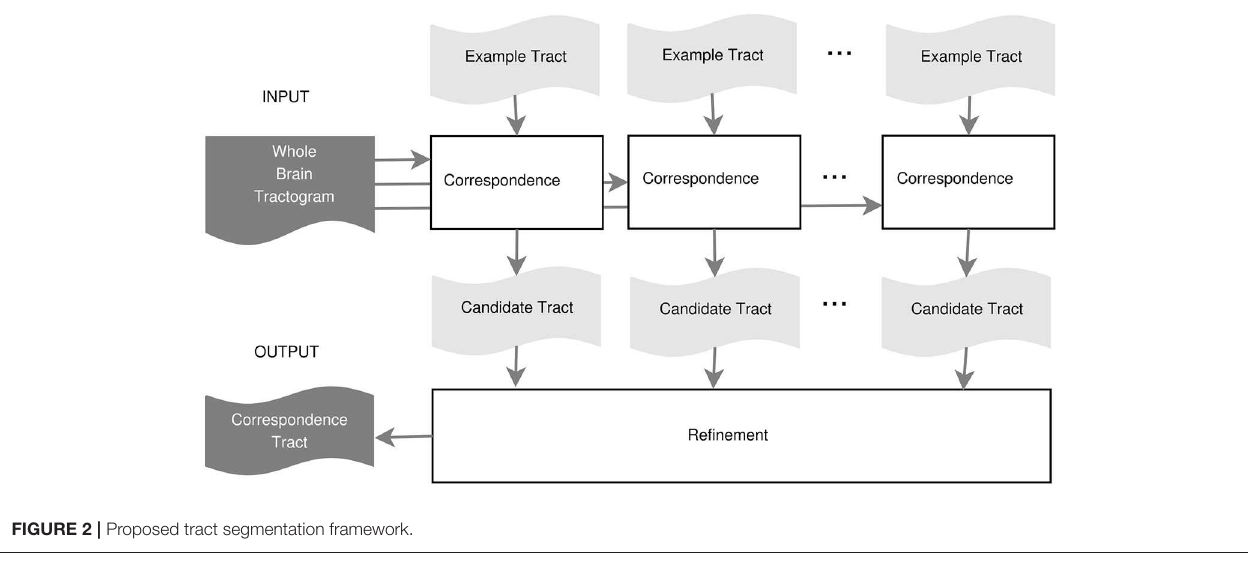
FIGURE 2 | Proposed tract segmentation framework.